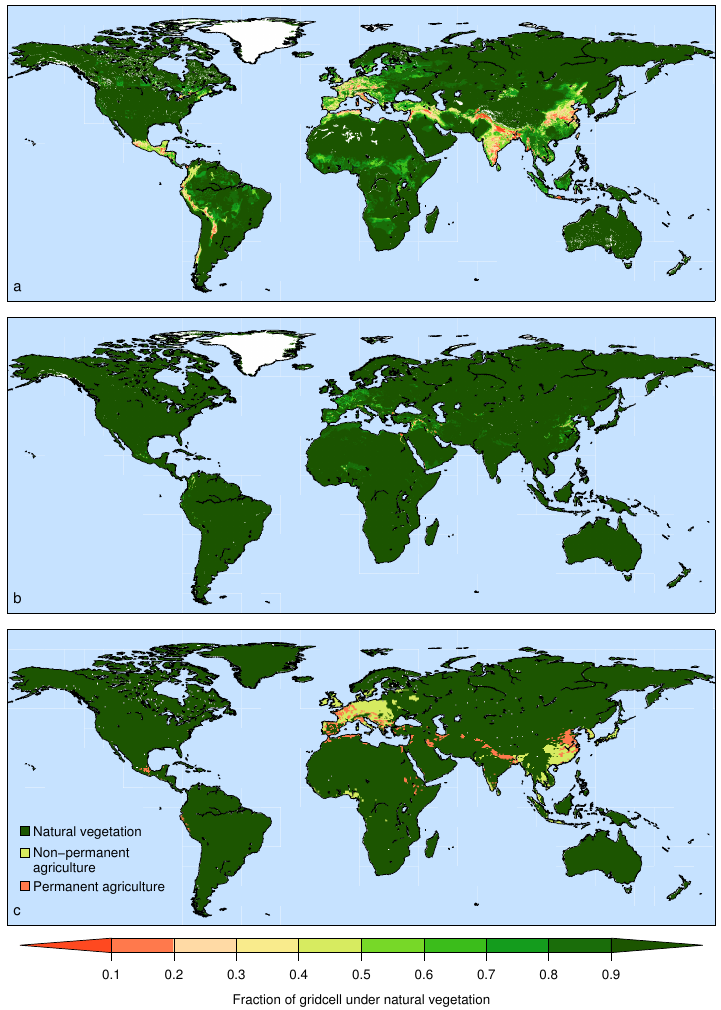
Fig. 5. Global anthropogenic land use at AD 1 simulated by three different approaches: (a) , Kaplan et al. (2009); (b) , HYDE [History Database of the Global Environment] version 3.1 (Klein Goldewijk et al., 2010); and (c) , Olofsson and Hickler (2008). Note that the colour scale is relevant for maps (a) and (b). Map (c) has its own colour